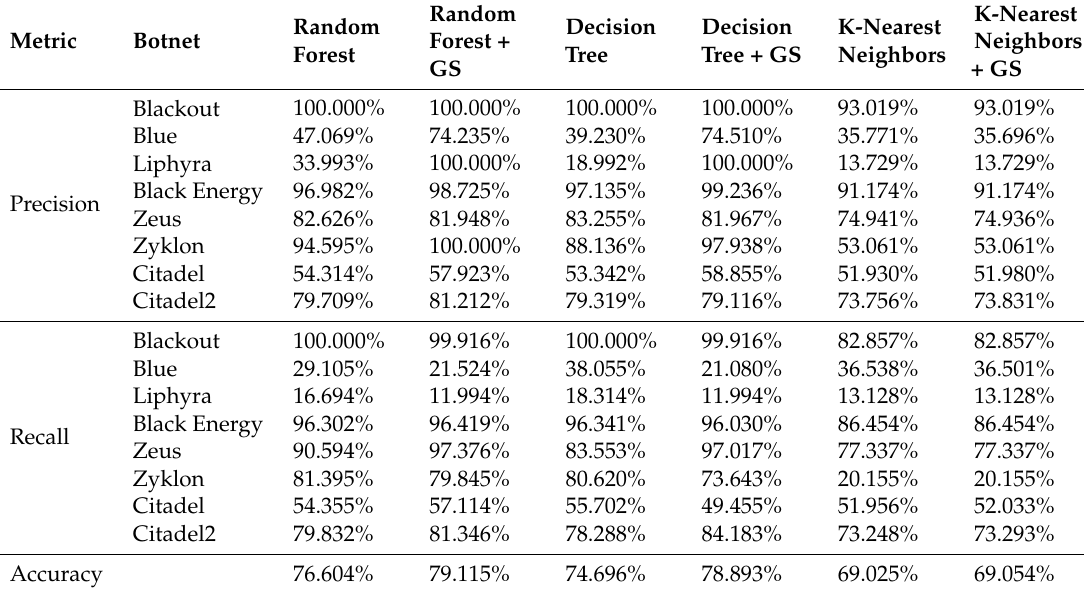
Table 5. Comparative analysis of ML models in the ISOT HTTP Botnet dataset